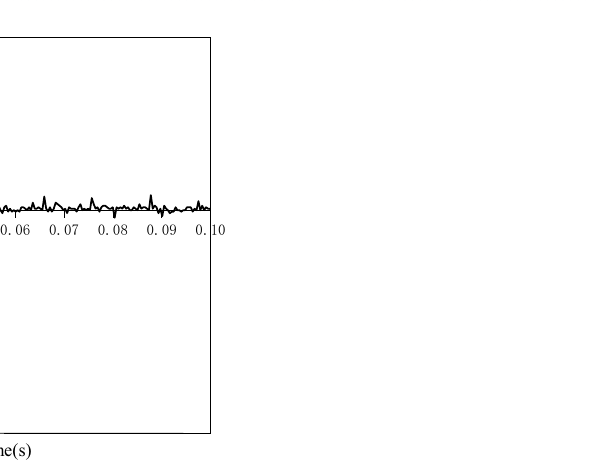
Figure 4. Signal response diagram under the influence of environmental